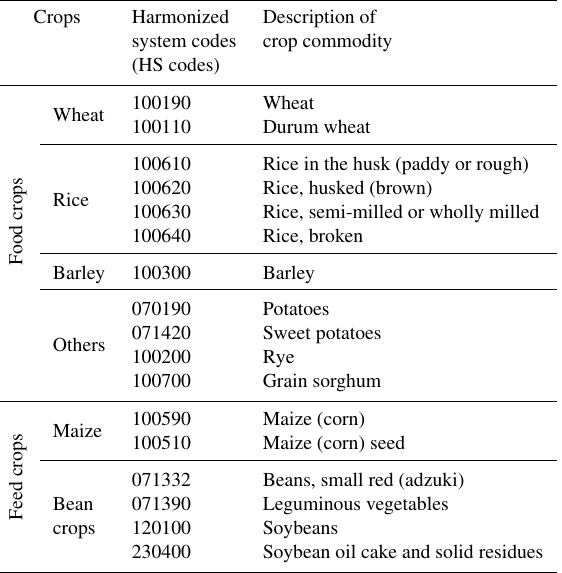
Table 1. Study crops for food and feed